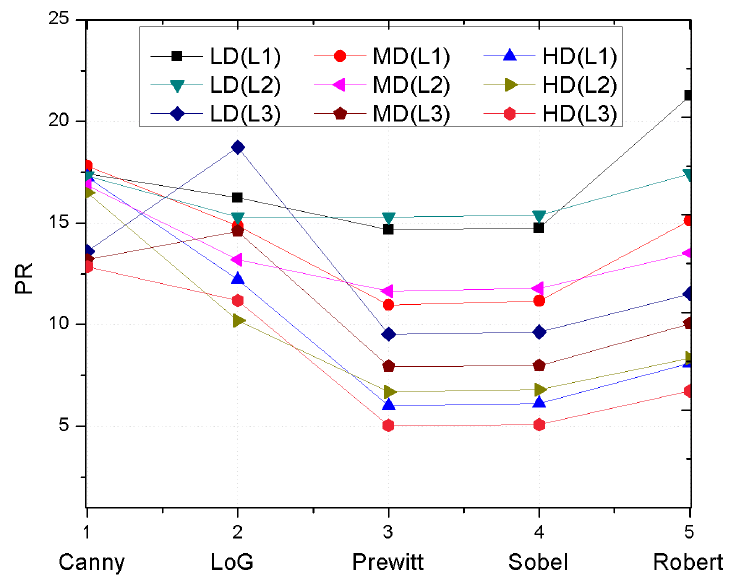
Fig. 12. PR values for the Haar wavelet